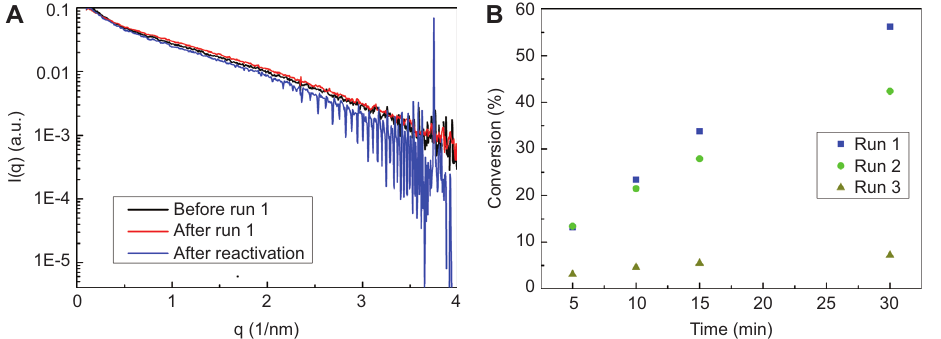
Figure 12 (A) SAXS curves of the Pd NPs in reaction solution before the first run (black), after the first run at quantitative conversion (red), and after the first reactivation prior to the second run (blue). (B) Conversion time plots for successive runs with recycled Pd NPs. Reaction conditions: 1 mmol benzyl alcohol, 25 μ mol Pd NP in 10 ml i PrOH/water (ratio 4/1), 50 ° C, NPs were reactivated after each